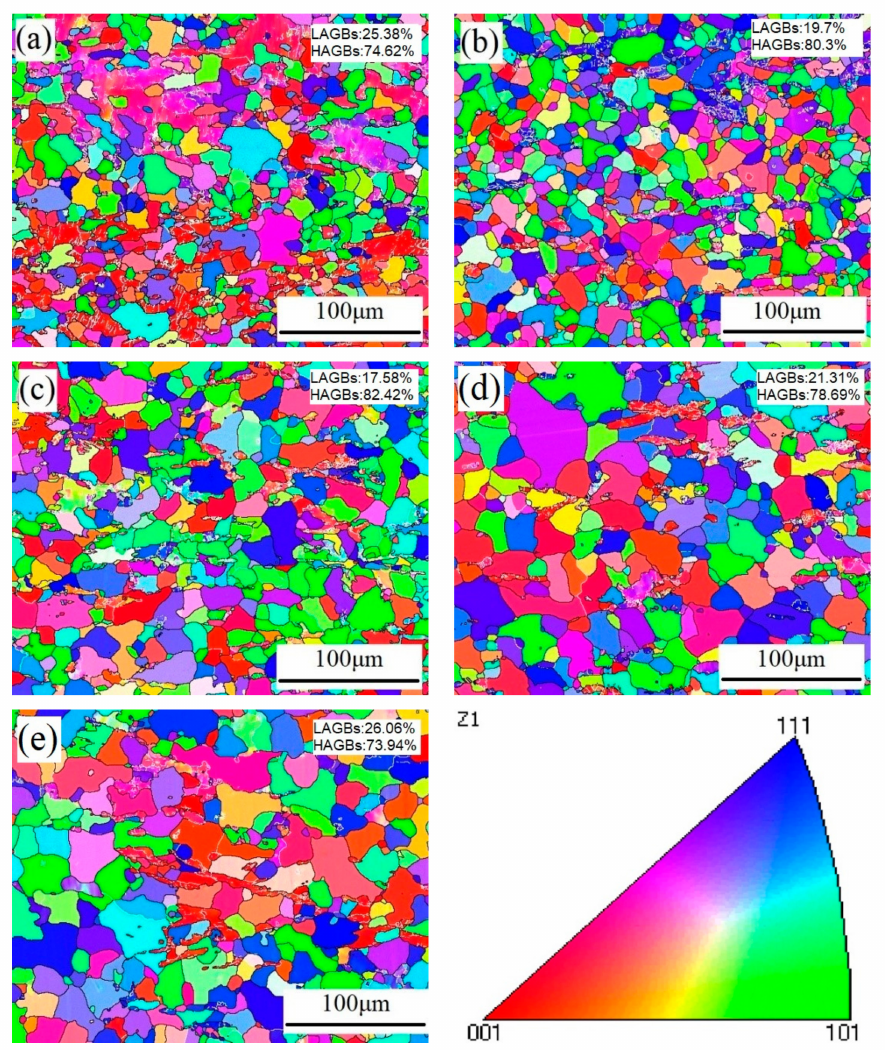
Figure 8. Orientation maps and inverse pole figure of 7085 and TiC / 7085 after T6 treatment ( a ) 7085; ( b ) 0.1 wt% TiC / 7085; ( c ) 0.3 wt% TiC / 7085; ( d ) 0.5 wt% TiC / 7085; ( e ) 1 wt% TiC /